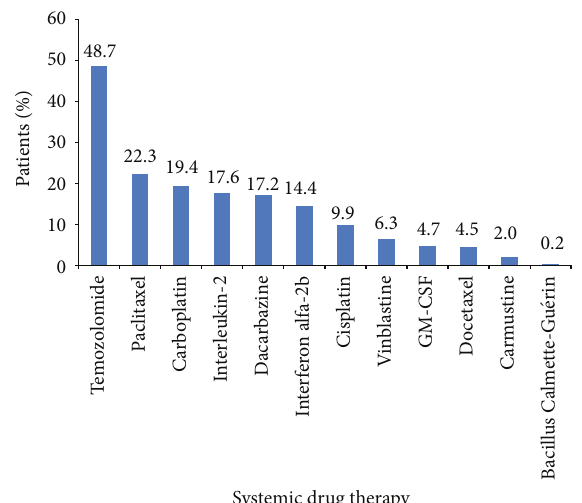
Figure 1: Treatment patterns among patients who received systemic drug treatment.